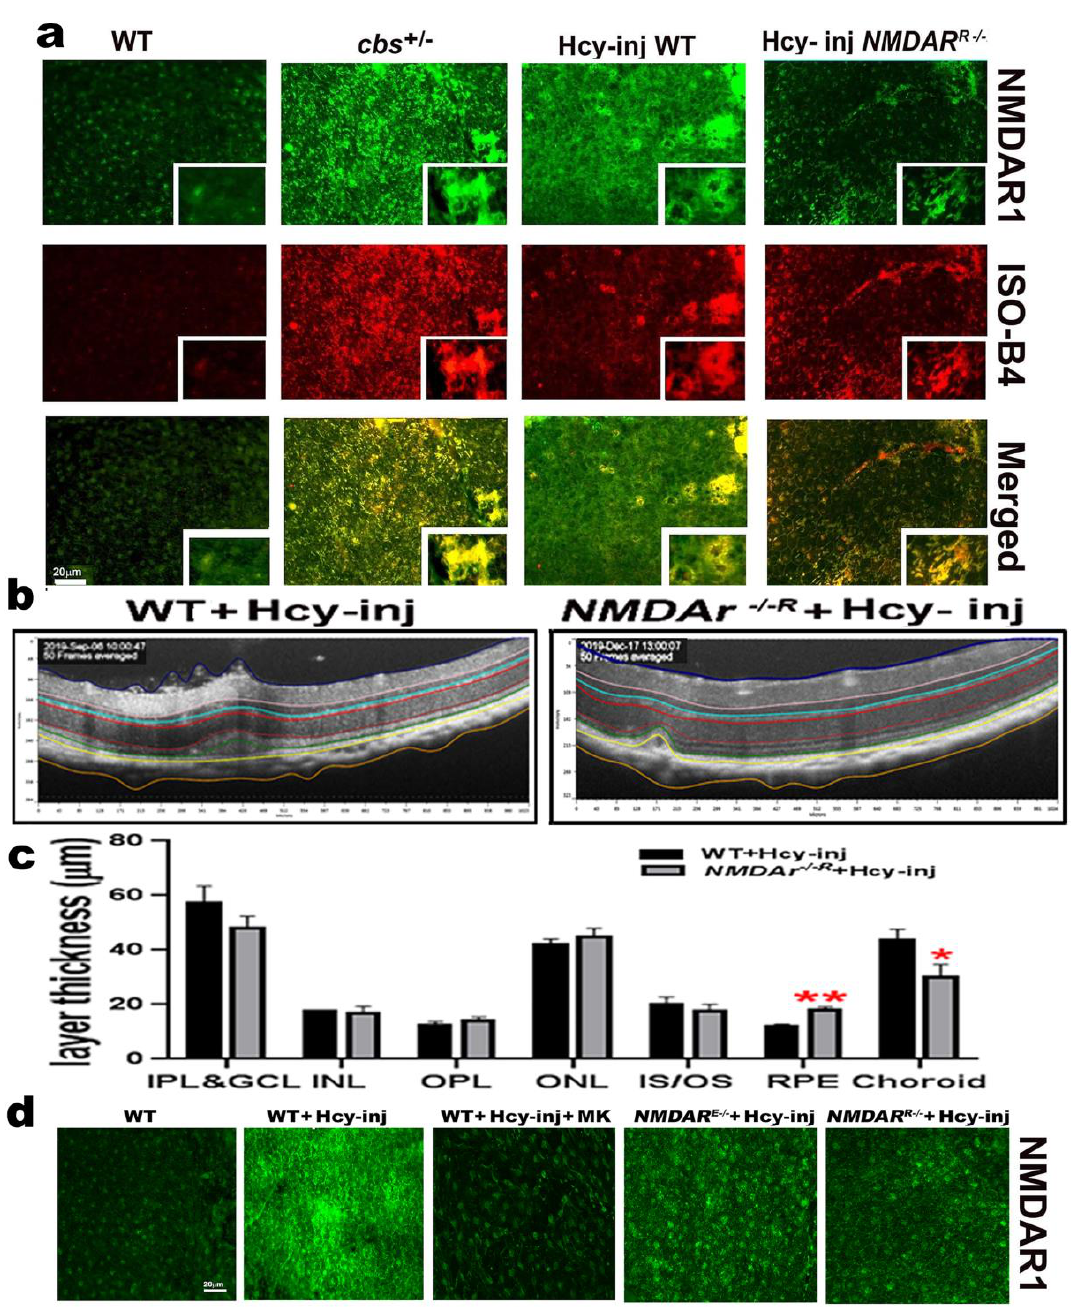
Figure 6. Deletion of NMDAR in RPE cells decreased Hcy-induced CNV in retinal flat mounts. ( a ) Immunofluores- cence staining for RPE flat-mounts isolated from mouse retinas after one week of intravitreal injection of Hcy in WT and NMDAR R − / − as compared to WT control non-injected mice and mice with HHcy ( cbs +/ − ) stained with a vascular marker using Isolectin-B4 (red) and NMDAR1 (green). Hcy injection induced choroidal neovascularization and activation of NMDAR, which was more evident in both mice models of HHcy ( cbs +/ − mice and Hcy-injected WT mice), while knocking down NMDAR in ( NMDAR R − / − ) was able to reduce CNV induction and NMDAR activation by Hcy injection. ( b ) OCT images and Insight ® software were used for assessment of the thickness of different retinal layers in wild-type and NMDAR R − / − mice 72 h after intravitreal injection of Hcy. ( c ) Analysis of retinal thickness of WT mice and NMDAR R − / − mice injected with Hcy showed an improved RPE layer and decreased CNV size in NMDAR R − / − mice. ( d ) Outer retina flat-mounts stained with an antibody for NMDAR (green), confirming that both the pharmacological (MK801) and the genetic inhibition of NMDAR were able to block the Hcy activation of NMDAR. ( n = 6 mice per group). Calibration bar: 20 µ m; * p < 0.05, ** p <